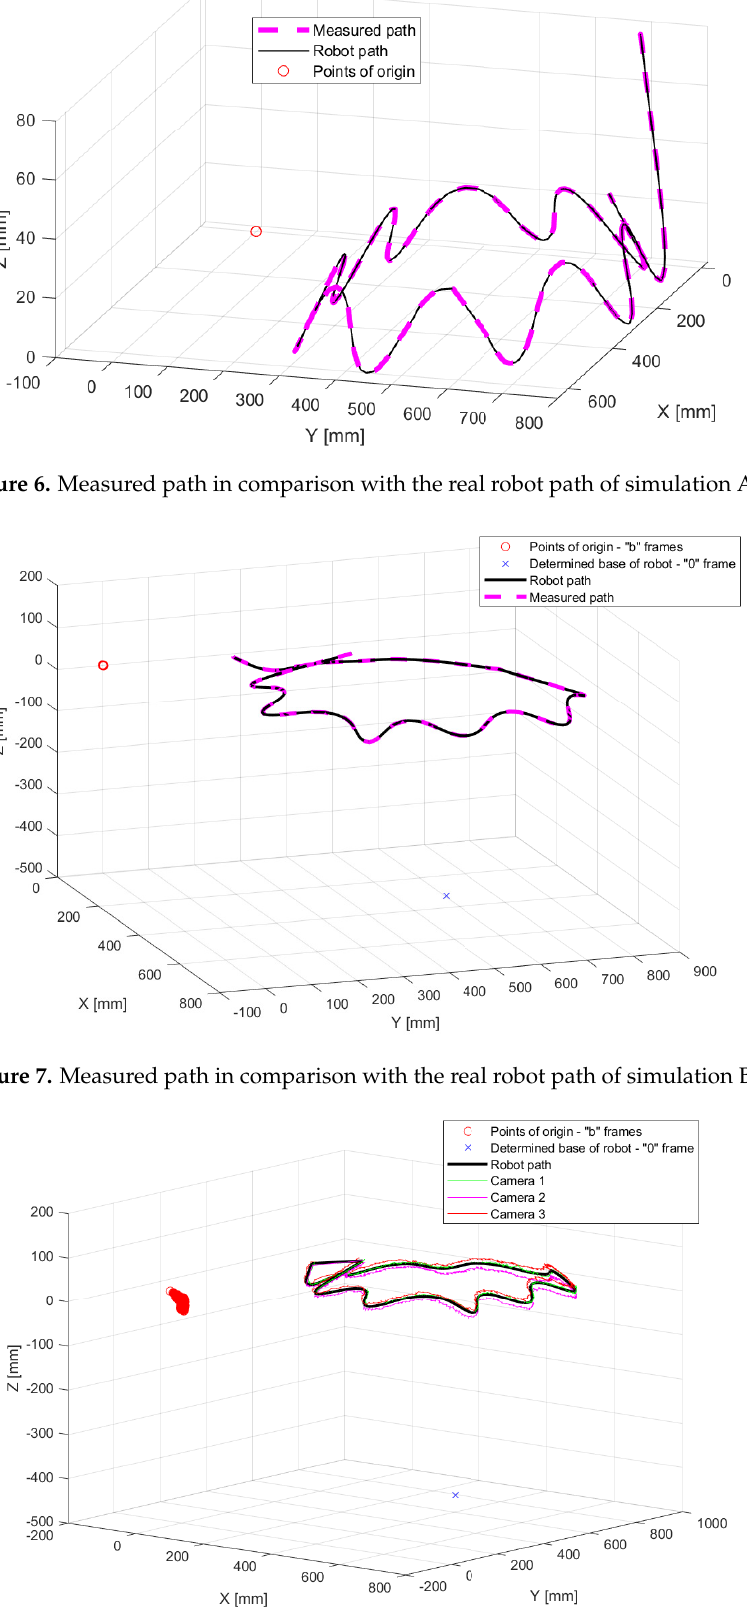
Figure 8. Paths measured by cameras in comparison with the real robot path of experiment